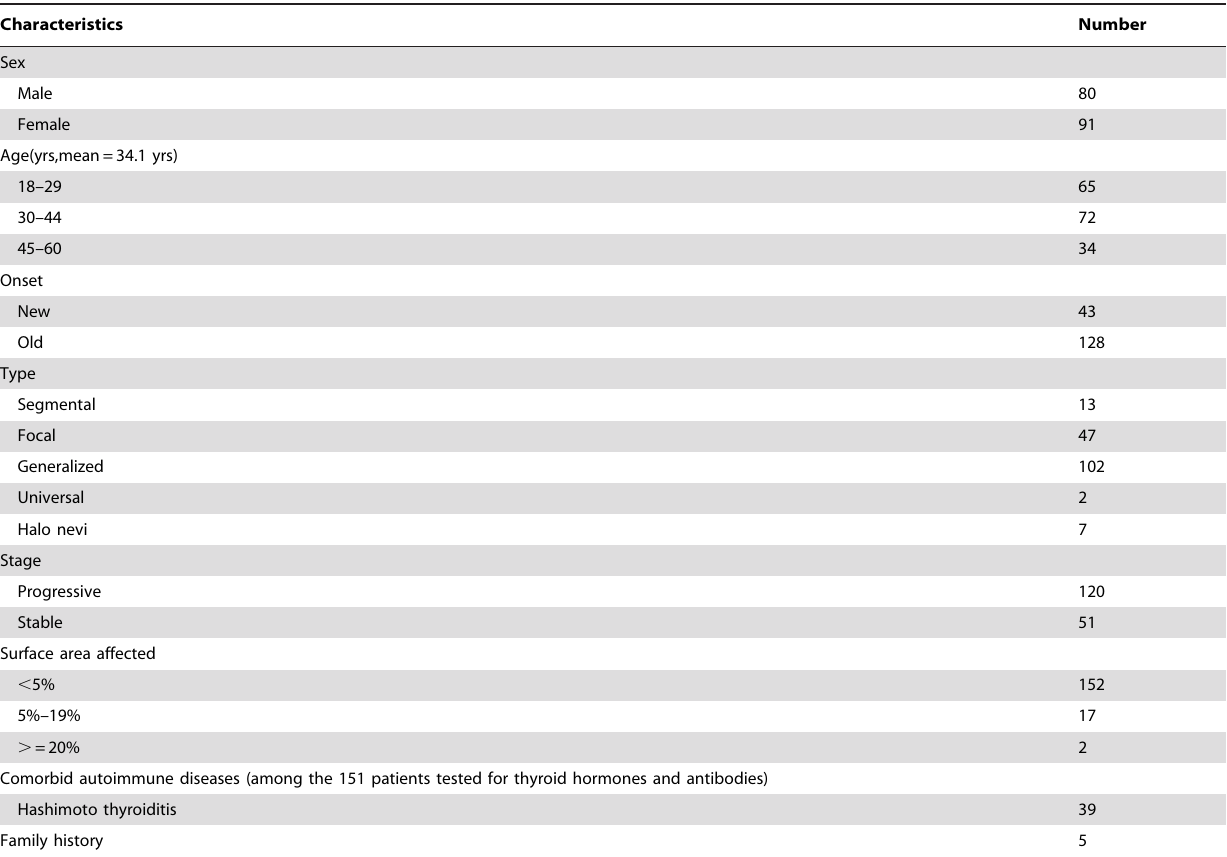
Table 1. Characteristics of the 171 patients included in case-control study from March to May.